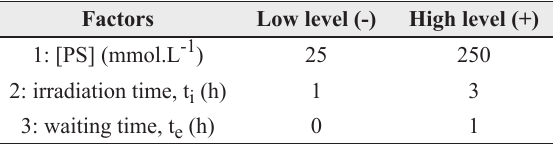
Investigated photodynamic activity factors with the levels used in A. salina bioassays.